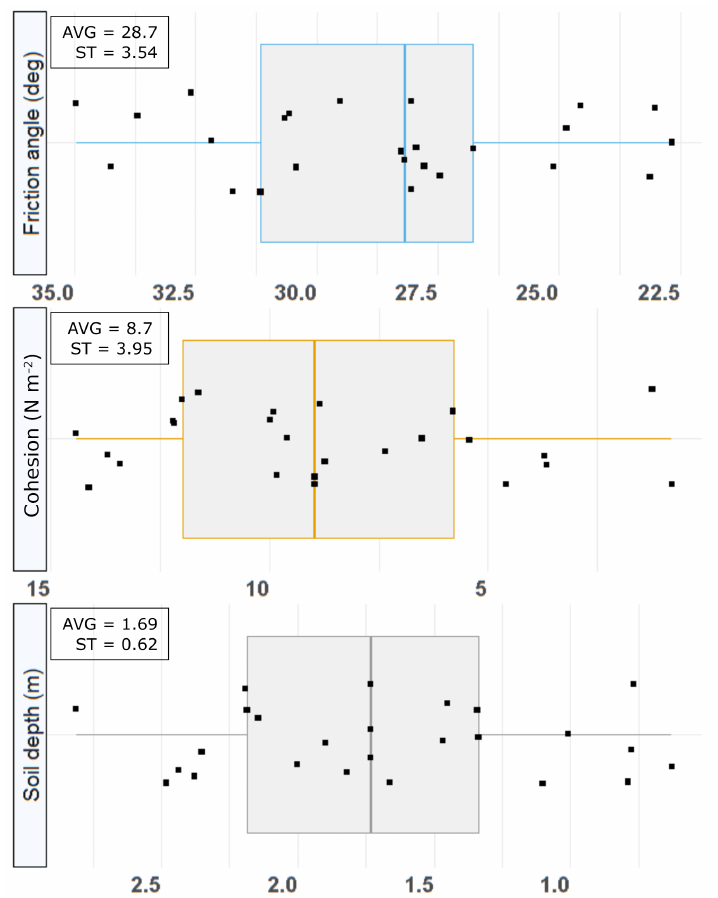
Figure 2. Probabilistically derived modeling parameters based on random sampling from a normally distributed function. Jittering dots (to prevent overplotting) indicate individual samples within a plausible parameter